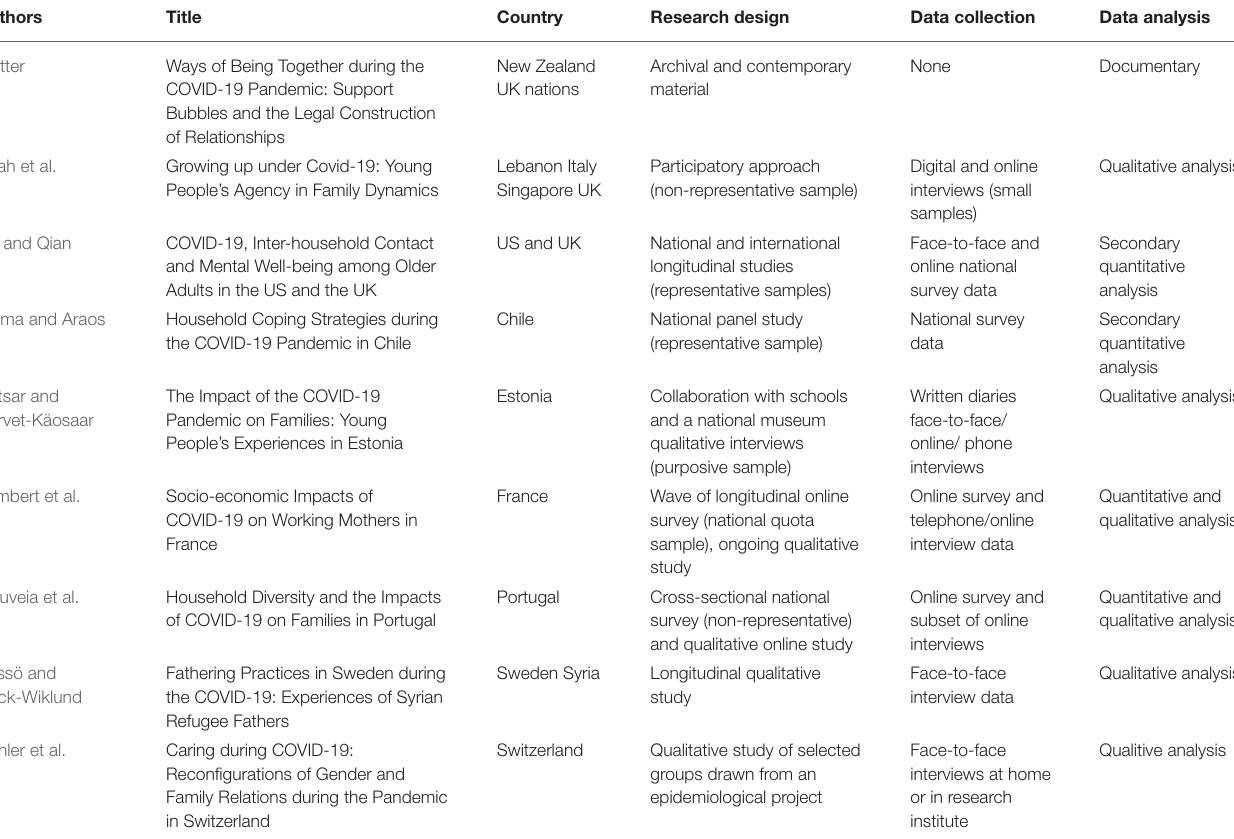
TABLE 1 | International and methodological perspectives on family